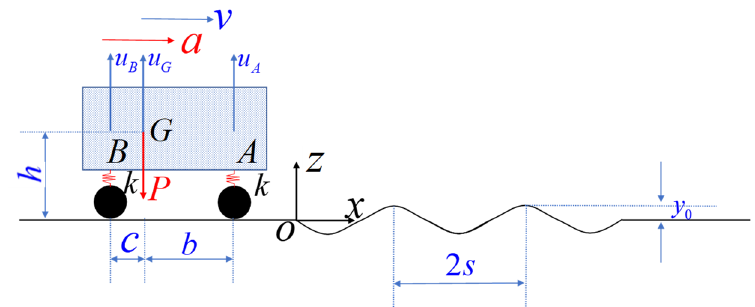
Figure 3. A simpli fi ed mechanical analysis of uneven pavement.